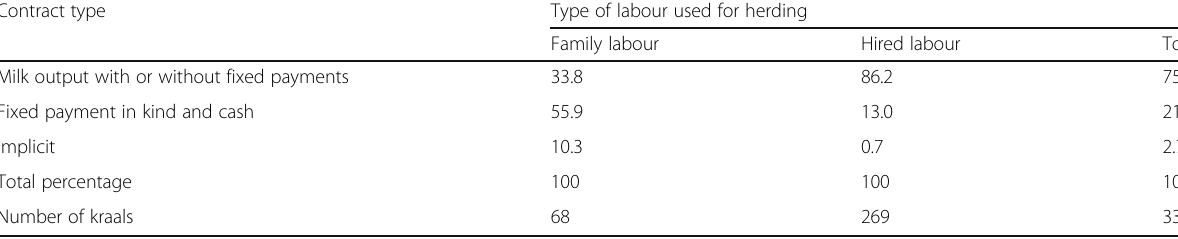
Table 5 Distribution (percentage) kraal owner – herdsman contract by labour type Contract